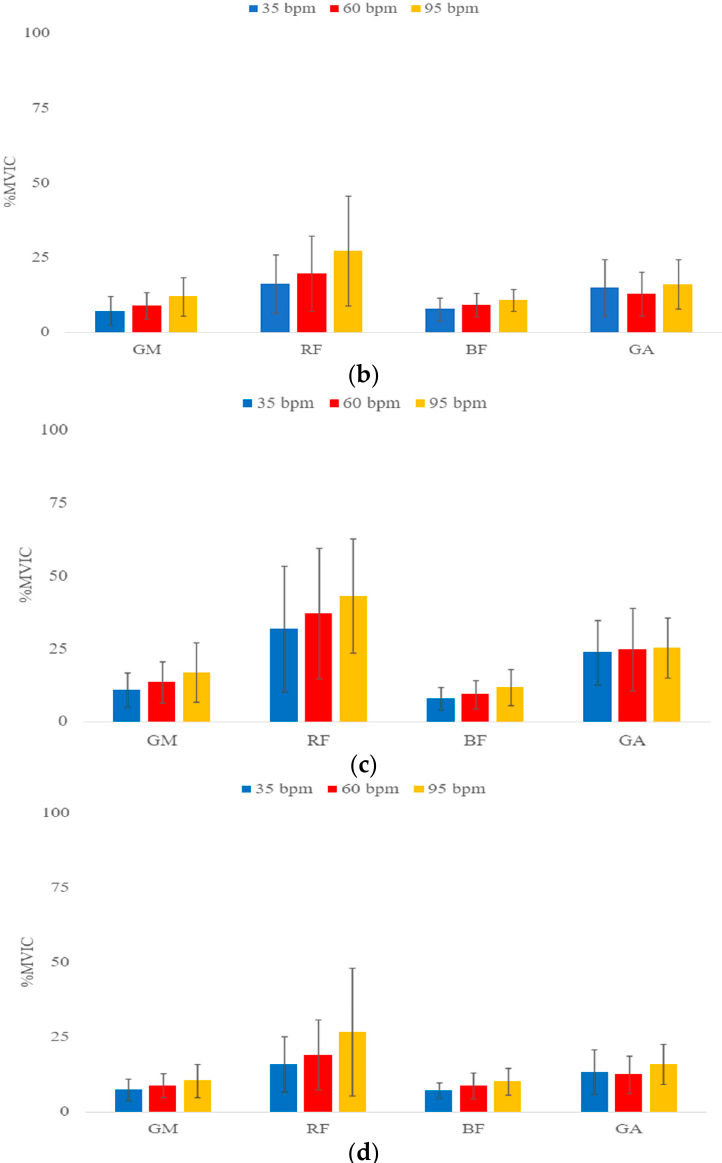
Figure 4. Means of percentage of maximum voluntary isometric contraction (%MVIC) for gluteus maximus (GM), rectus femoris (RF), biceps femoris (BF), and gastrocnemius (GA) performed during ( a ) ascending phase on land, ( b ) ascending phase in water, ( c ) descending phase on land, and ( d ) descending phase in water.